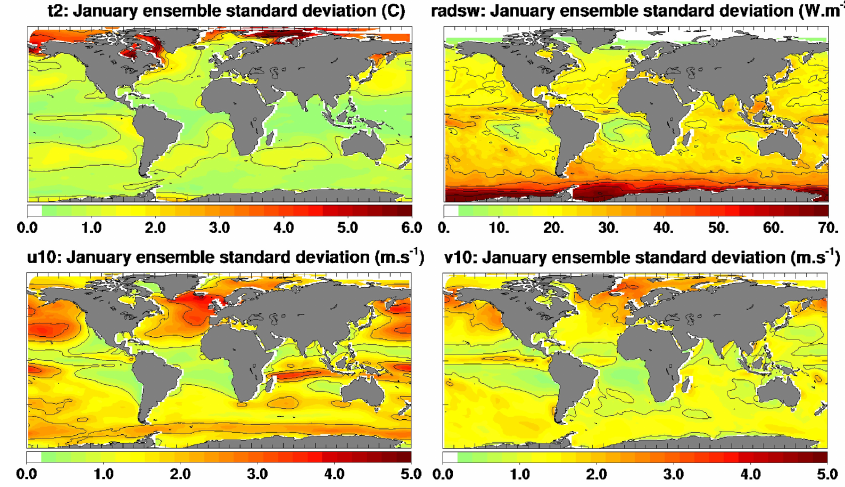
Fig. 2. January ensemble standard deviation in terms of air temperature (top left), shortwave radiation (top right), zonal wind speed (bottom left), and meridional wind speed (bottom